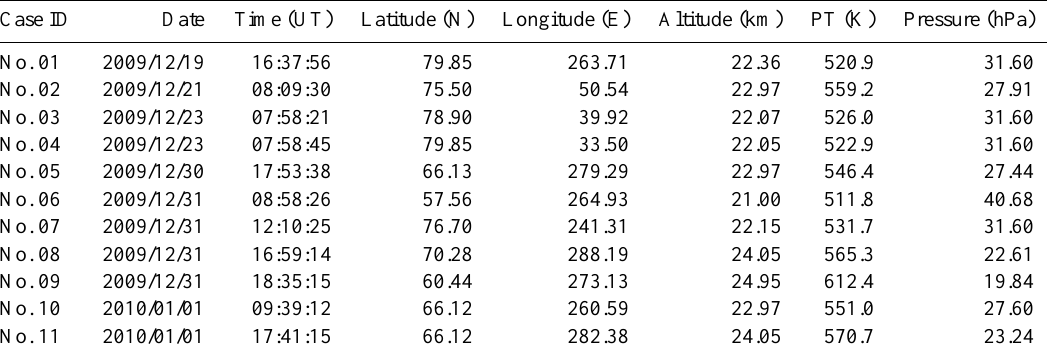
Table 1. List of the selected cases for the trajectory runs. The first column shows the ID number of the case used in the following analysis, the second column the starting date, and the third column the starting time of the trajectory. The remaining columns show the location of the starting position ( t = 0) of the forward and backward